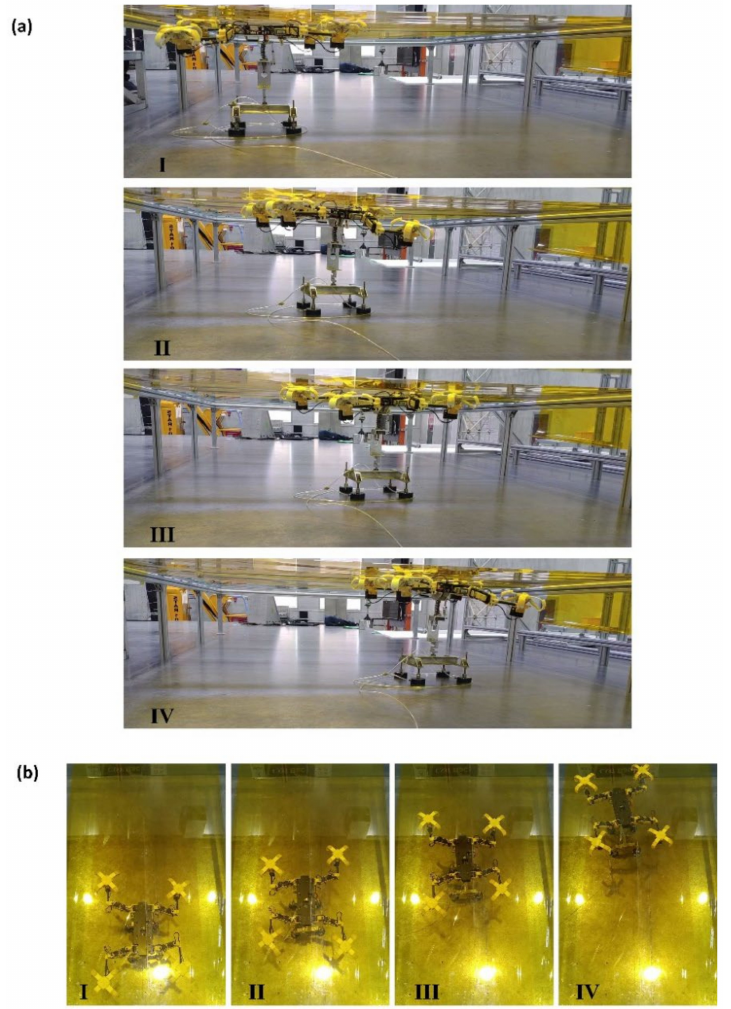
Figure 18. Experiment of gecko-inspired robot crawling on flexible surface: ( a ) Adhesion climbing experiment of gecko-inspired robot on flexible surface by using air floating platform (side view); ( b ) adhesion climbing experiment of gecko-inspired robot on flexible surface by using air floating platform (top